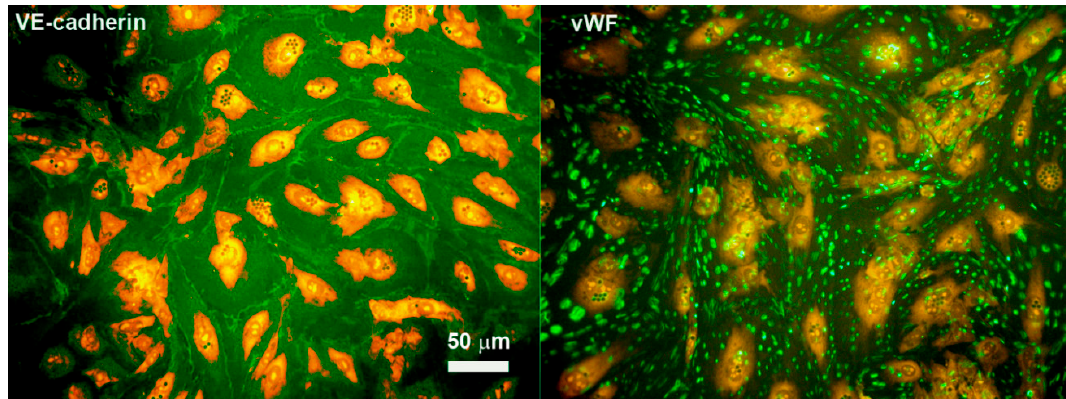
Figure 2. Characterization of decidual endothelial cells (DECs) by immunofluorescence. DECs isolated from first trimester human decidua were labelled with FastDiI (in red) and stained with VE-Cadherin or von Willebrand factor (vWF) (in green). The cells resulted 100% positive for the expression of these pan-endothelial cell markers. The images were acquired by microscope Leica DM3000. Original magnification 200×, scale bar, 50 μ m.